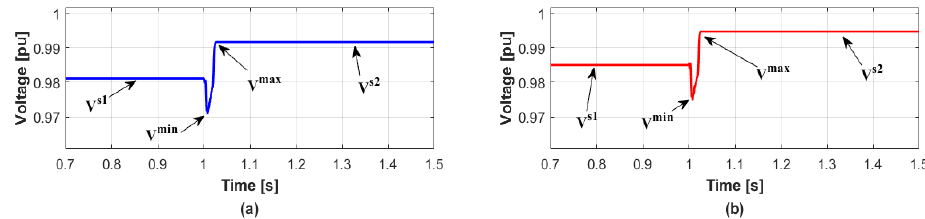
Figure 4. Voltage responses without the reactive power compensation in Case 1. ( a ) Bus 2 ( b ) Bus